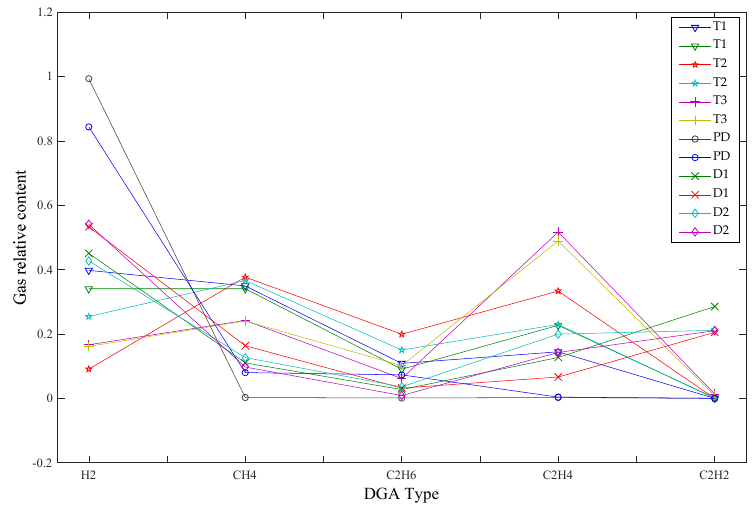
Figure 1. Line chart of DGA gas content of 12 fault transformers.